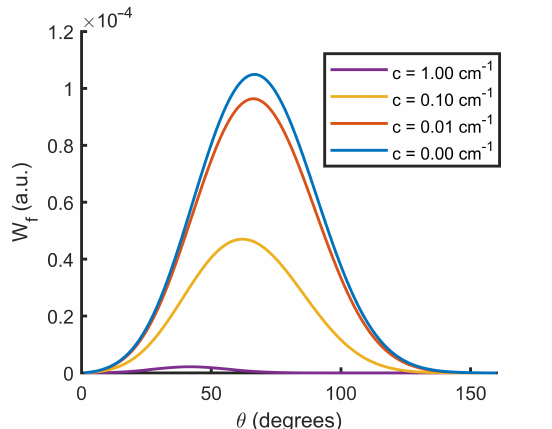
Figure 8. Angular weighting function ( W f ) as a function of the scattering angle ( θ ) for different attenuation coefficients ( c